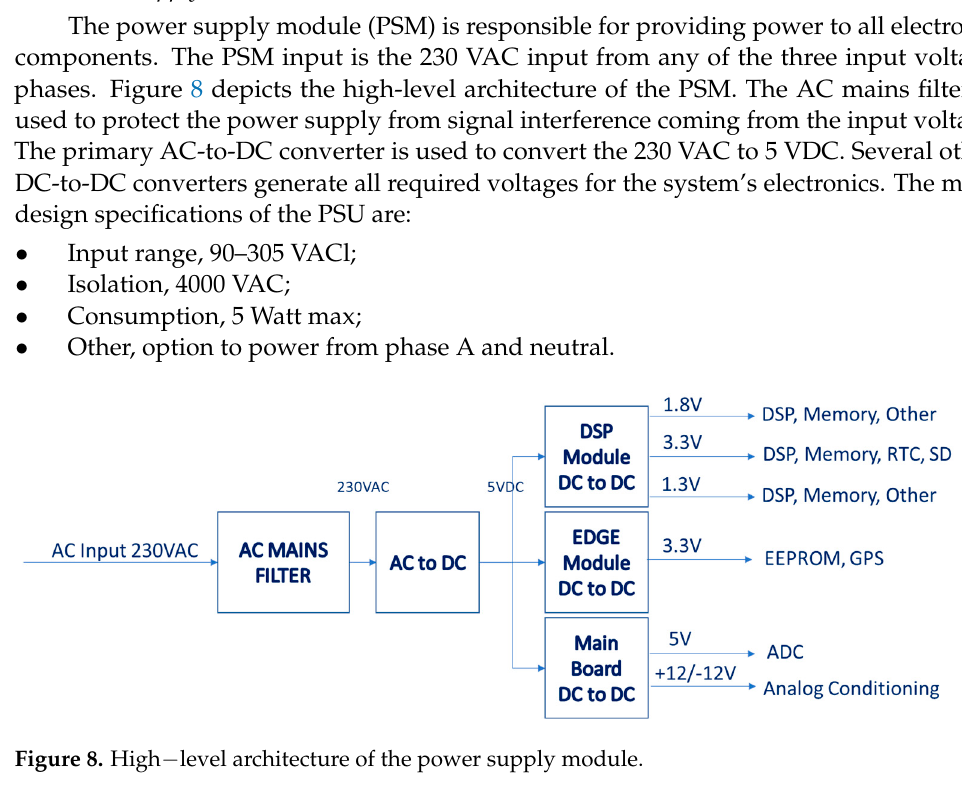
14 of 30 Figure 7. High-level architecture of the edge processing module application.